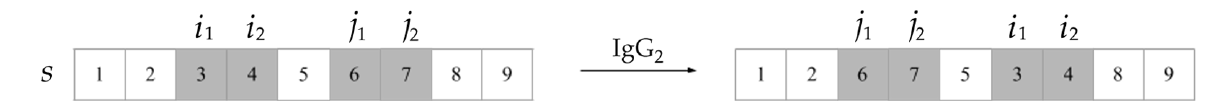
Figure 7. The operation of IgA mode.